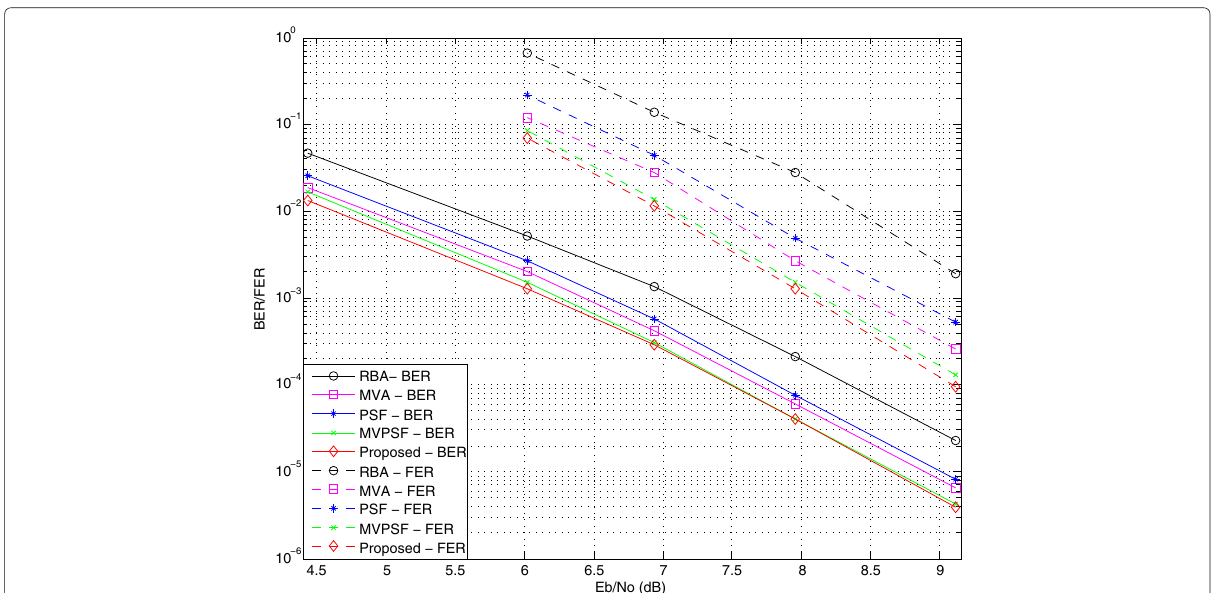
Fig. 3 Comparison of decoder BER performance for 63 × 37, GF(16) LDPC